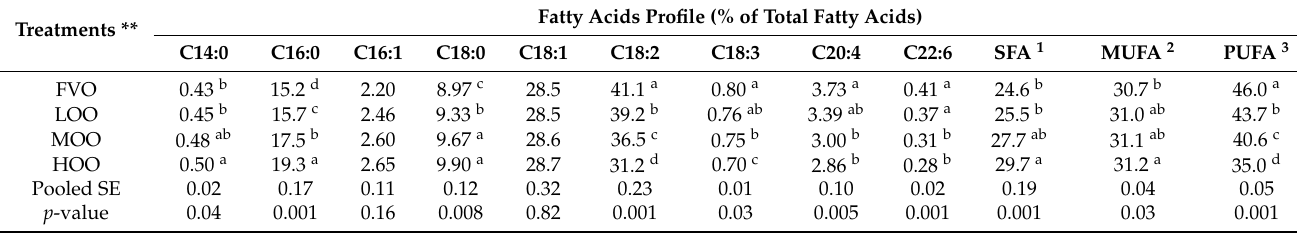
Table 5 indicates the effects of oxidized vegetable oil on the meat fatty acid profile of broilers. The concentrations of SFA, myristic acid (C14:0), palmitic acid (C16:0) and stearic acid (C18:0) were increased ( p < 0.05), whereas PUFA, linoleic acid (C18:2), linolenic acid (C18:3), arachidonic acid (C20:4) and docosahexaenoic acid (C22:6) concentrations were reduced ( p < 0.05) with the supplementation of LOO, MOO and HOO in the broiler diets than those fed with the FVO diet. The broilers consuming LOO-containing diets resulted in 4, 5, 3 and 4% increased concentrations of SFA, C14:0, C16:0 and C18:0, whereas 5, 5, 5, 9 and 10% reduction in the concentrations of PUFA, C18:2, C18:3, C20:4 and C22:6, respectively, than those consuming FVO based diets. The supplementation of MOO in the broiler diets led to 13, 12, 15 and 8% increase in the concentrations of SFA, C14:0, C16:0 and C18:0, whereas 12, 11, 6, 20 and 24% decrease in the concentrations of PUFA, C18:2, C18:3, C20:4 and C22:6, respectively, compared with those fed FVO-based diet. The broilers fed with HOO based diets indicated 21, 16, 27 and 10% higher concentration of SFA, C14:0, C16:0 and C18:0, whereas 24, 24, 13, 23 and 32% lower concentrations of PUFA, C18:2, C18:3, C20:4 and C22:6, respectively, than those consuming FVO in the diets. Table 5. Effects of oxidized vegetable oil on meat fatty acid profile of broilers *. Fatty Acids Profile (% of Total Fatty Treatments **